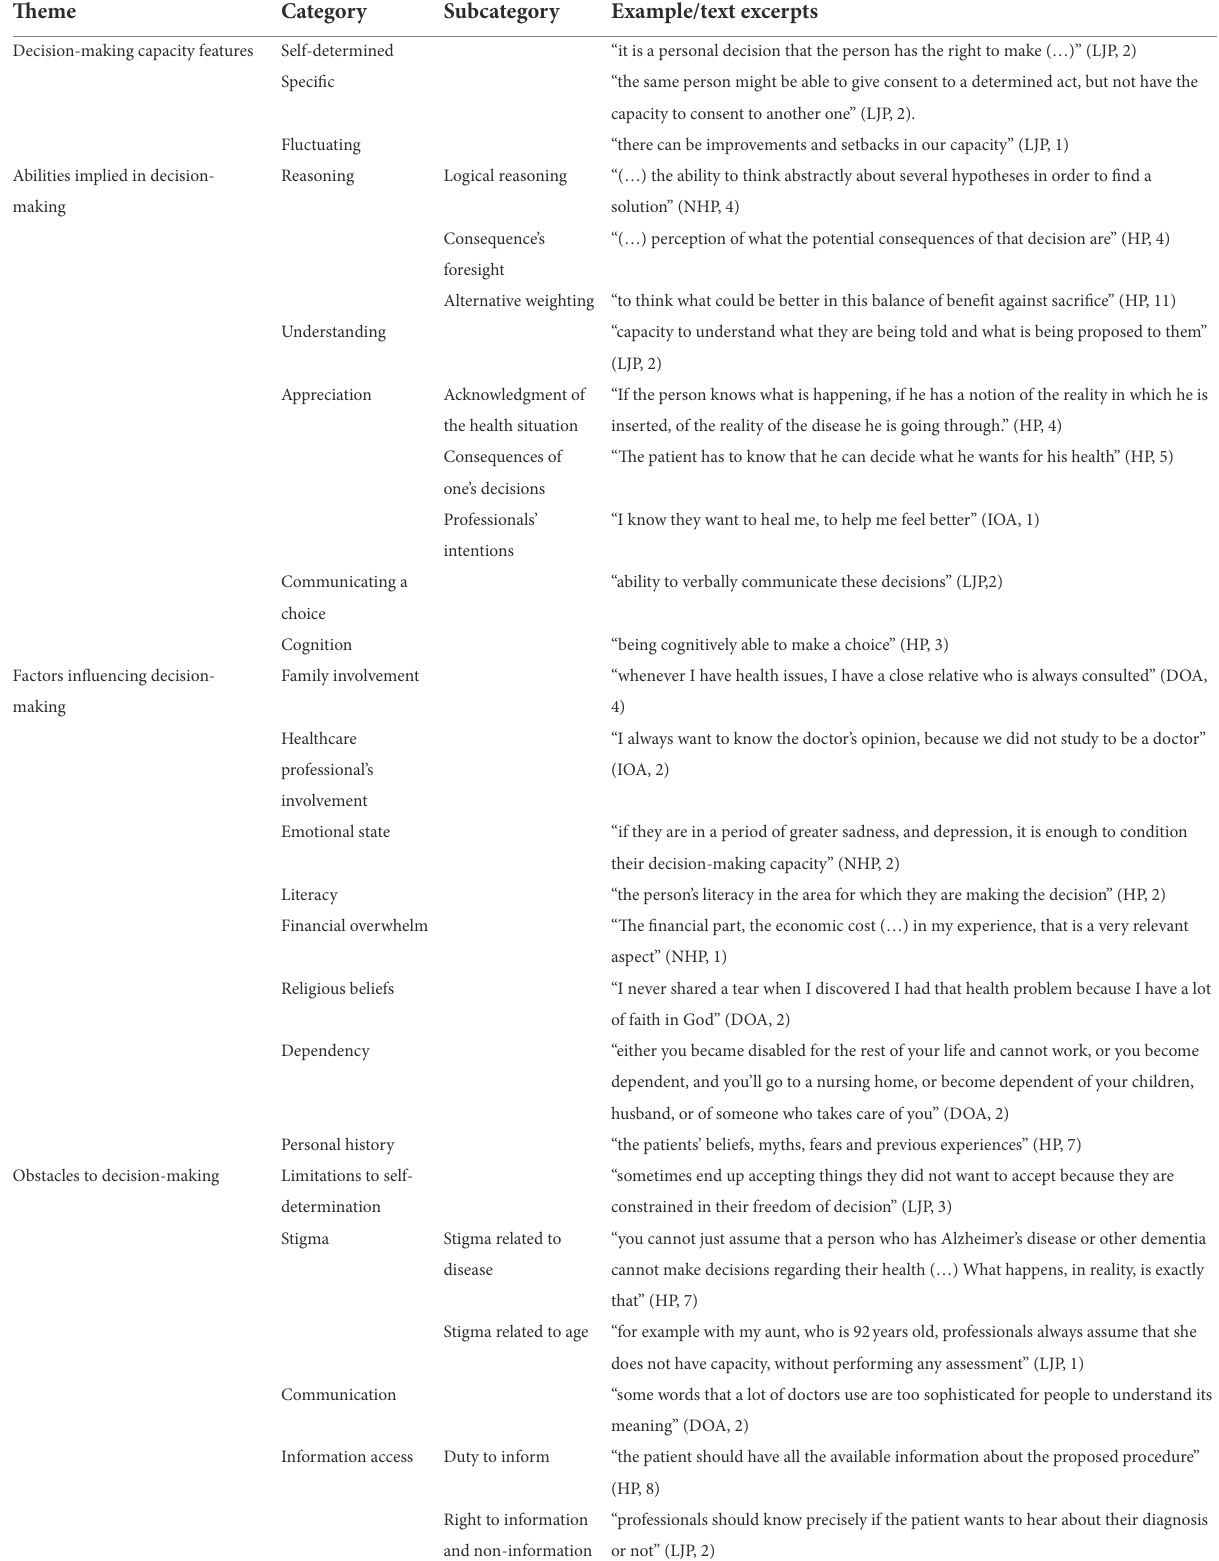
TABLE 2 Content analysis